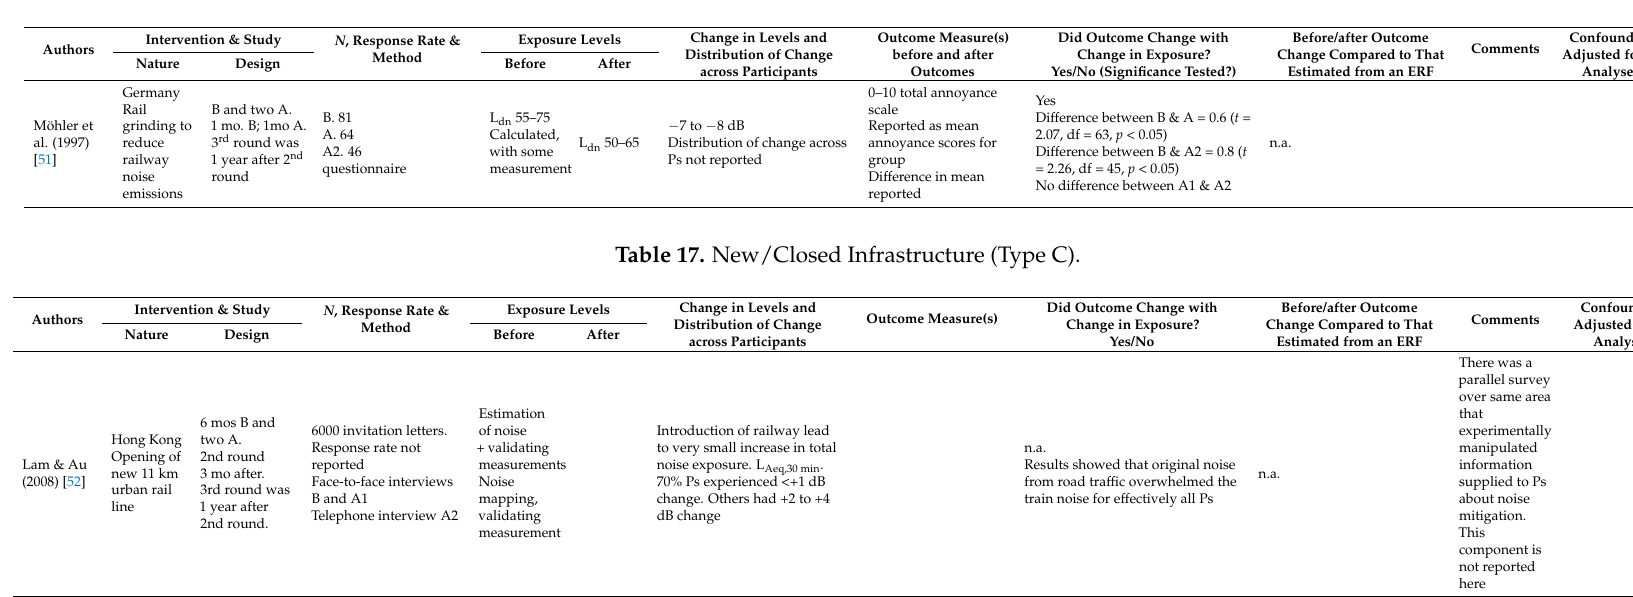
Table 16. Source Interventions (Type A).